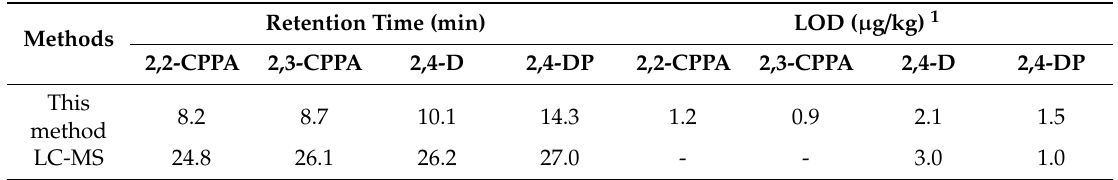
Table 4. Comparison of the proposed online hydrophobic in-tube SPME-HPLC method with the standard method of